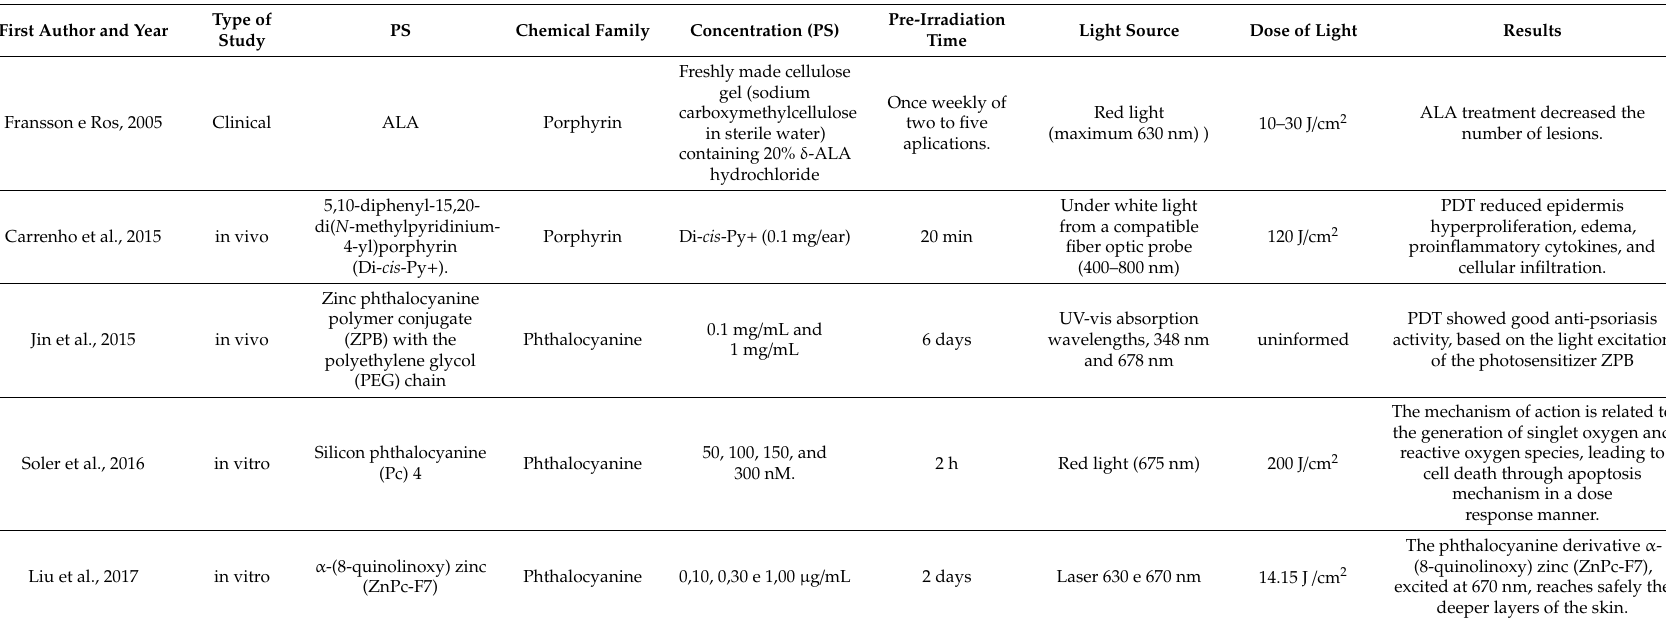
Table 3. Descriptions of studies using porphyrins and phthalocyanines in the treatment of